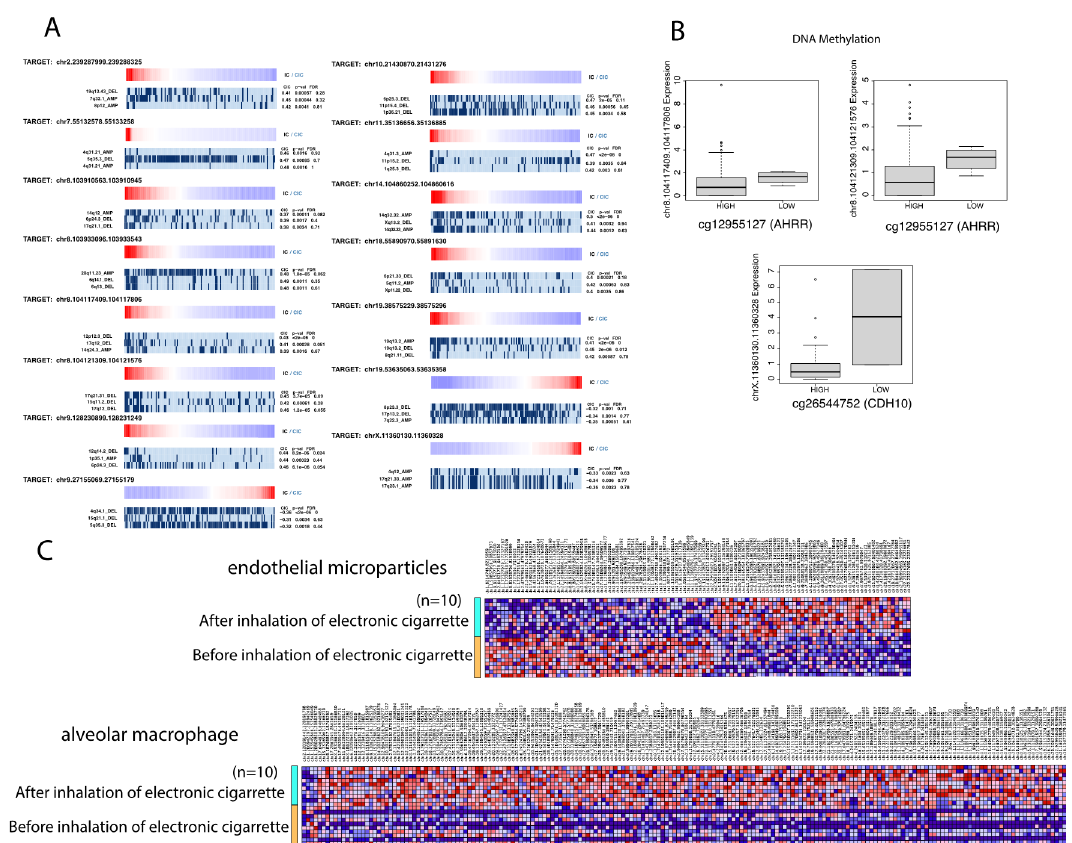
Figure 5. Genomic alteration correlation to 16 key eRNAs via REVEALER ( A ) Mutation heatmaps with red on the left side indicating that an eRNA is overabundant, while red on the left side indicates that the eRNA is under abundant. The following rows below the heatmap specify copy number variant (CNV) type/genetic variants (alteration, deletion, mutation) across all samples. Each bar represents the presence or absence of a CNV in one sample. Correlations were measured using the Repeated Evaluation of Variables Conditional Entropy and Redundancy (REVEALER) algorithm (CIC > |0.3|, p < 0.05); 15/16 plots are shown here as the algorithm failed to produce a plot for chr12.51786511.51786834. ( B ) Boxplots correlating eRNA expression with the extent of methylation at CpG sites. In this analysis, the M-values were converted to a binary and categorical variable of “HIGH” and “LOW” in order to conduct the Kruskal–Wallis statistical test. The median abundance level for each eRNA across all samples was calculated. Values lower than the median value were assigned an abundance level of “LOW,” and values above the median value were assigned an abundance level of “HIGH.” The x -axis refers to the extent of methylation at the CpG site, and the y -axis refers to the eRNA expression level. ( C ) Heatmaps comparing significantly differentially expressed eRNAs in both endothelial microparticles and alveolar macrophages before/after electronic cigarette inhalation ( n = 10).